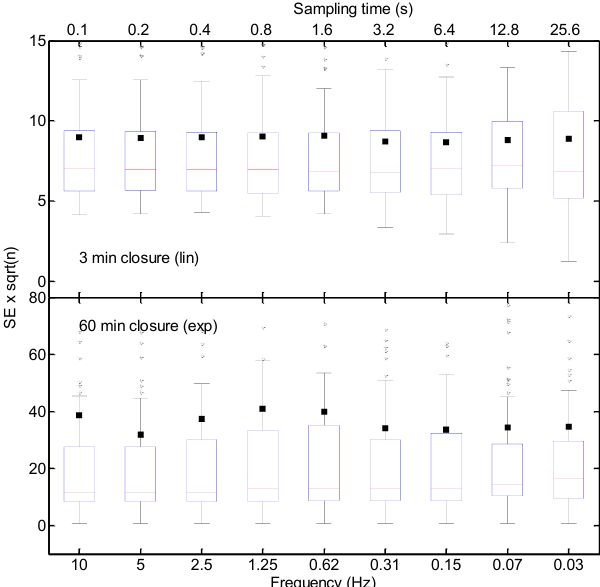
Figure 5. Box plots of standard errors of N 2 O fluxes for different frequency classes and regression models used, i.e., linear regression with 3min of data (upper panel) and the exponential HMR model with 60min of data (lower panel). To avoid a pseudo-dependency on sample size, the standard errors (SEs) were normalized by mul- √ n . Black squares represent the arithmetic mean, tiplication with red horizontal lines indicate the median, blue horizontal lines indi- cate lower and upper quartile values, black whiskers represent the interquartile range, and outliers from this range are plotted as grey